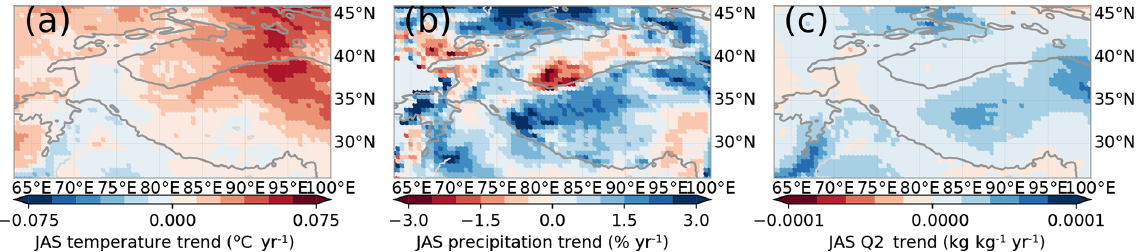
Figure 17. WRF trends between 1980 and 2010 of near-surface temperature (a) , total precipitation (b) , and specific humidity (c) between July and September, averaged over 0 . 5 ◦ × 0 . 5 ◦ bins for clarity. The 2000m elevation contour is indicated by a solid